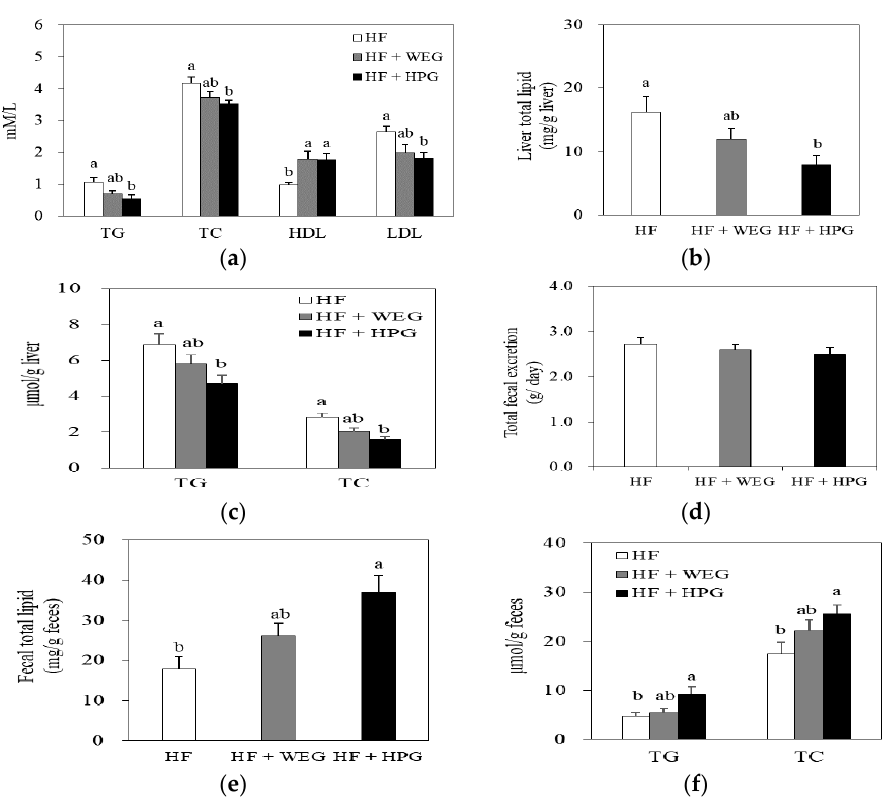
Figure 4. Effects of WEG and HPG on lipid profiles of serum, liver and feces. ( a ) Serum lipid profiles; ( b , c ) liver lipid profiles; ( d ) total fecal excretion; and ( e , f ) fecal lipid profiles. Values are expressed as mean ± SEM ( n = 9/group). a,b Mean values with unlike superscript letters are statistically different at p < 0.05. HF: high fat; WEG: hot water extract of ginger; HPG: high-hydrostatic pressure extract of ginger; TG: triglyceride; TC: total cholesterol; HDL-C: high-density lipoprotein cholesterol; LDL-C: low-density lipoprotein cholesterol.